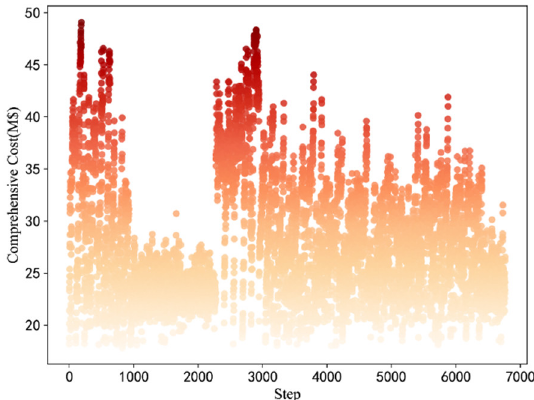
Figure 12. Indicator of comprehensive cost in the upper-level model.